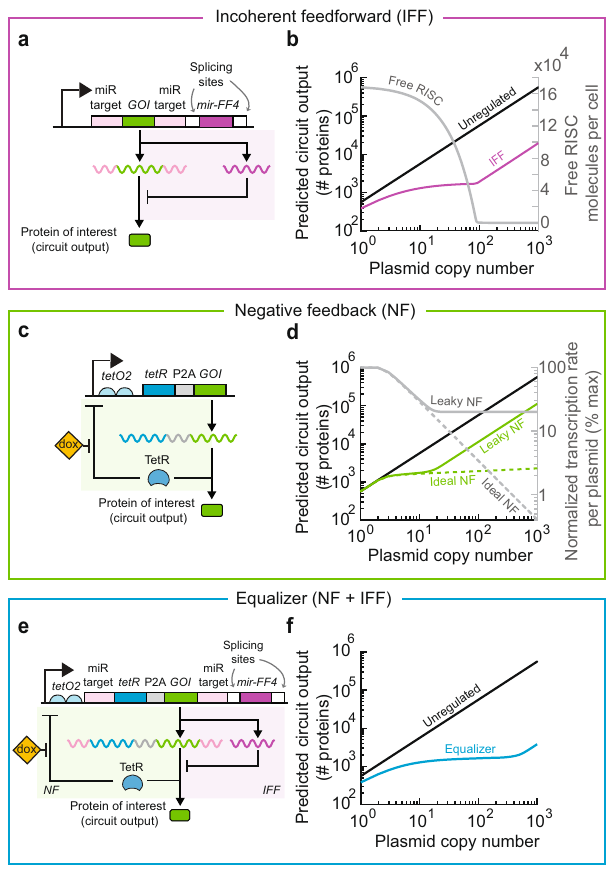
Fig. 2 Combining incoherent feedforward (IFF) and negative feedback (NF) loops is predicted to widen the copy number range with ef fi cient dosage compensation. a Schematic of the miRNA-based post- transcriptional IFF circuit. b The depletion of free RISC (gray trace) at high plasmid copy numbers abolishes dosage compensation by the IFF circuit (purple trace). c Schematic of the transcriptional NF circuit. d Incomplete repression by TetR results in a higher baseline transcription rate per plasmid (solid gray trace) that narrows the compensation range (leaky vs. ideal NF). Simulations were run with a doxycycline concentration that resulted in a wide compensation range of the NF circuit (1 ng/mL for both the ideal and leaky NF loops; see Supplementary Fig. 2). e Schematic of the Equalizer circuit, which combines transcriptional NF (green shaded area) with post-transcriptional IFF (purple shaded area). f Equalizer has the potential for compensating for a wider range of plasmid copy numbers than NF and IFF circuits alone. Simulated doxycycline concentration, 1